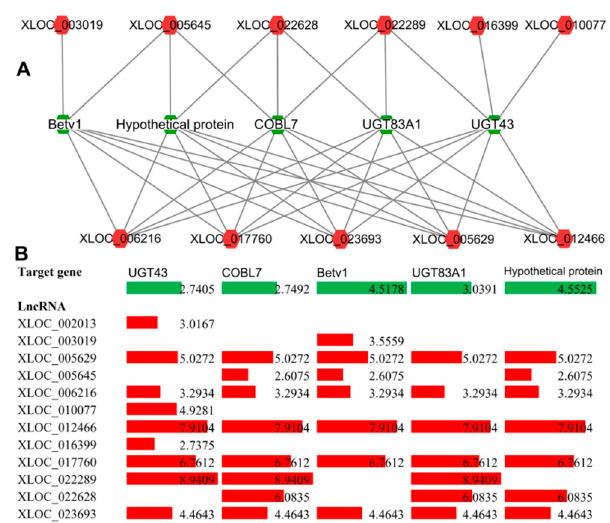
Figure 10. The top five target genes of the interaction network among lncRNAs and target protein-coding genes. (A) Co-expression network. The circle nodes represent lncRNAs and protein-coding genes, and edges show regulatory interactions among nodes. (B) Data bars with different colors show the expression levels of lncRNAs (colored in red) and target protein-coding genes (colored in green) under boron deficiency conditions.